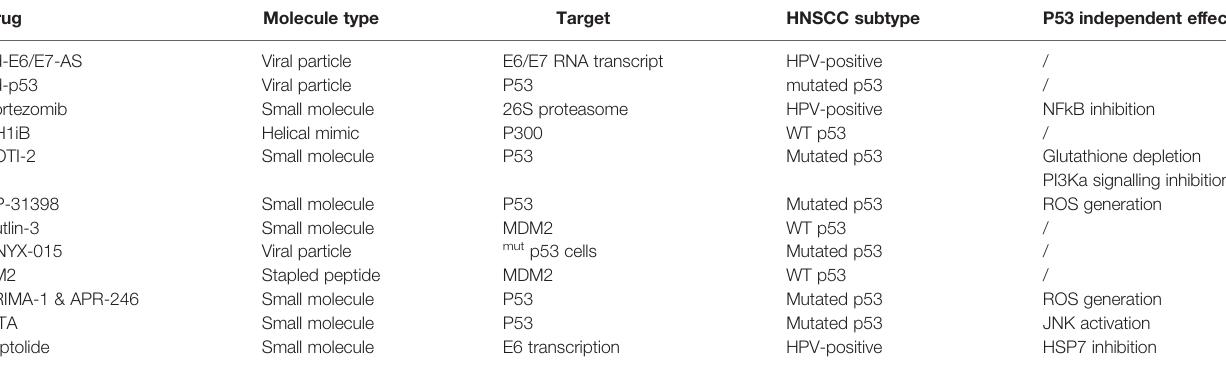
TABLE 1 | The different types of molecules and mechanisms used to reactivate p53 by targeting either p53 directly or another protein preventing p53 activity.